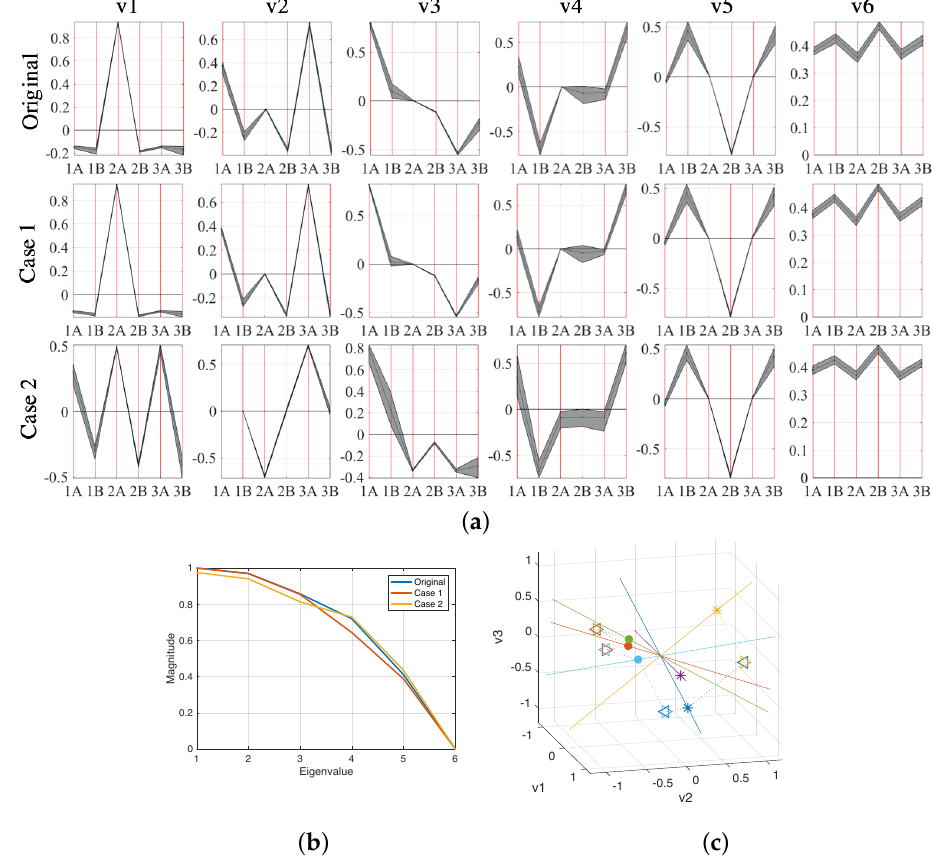
Figure 3. Details of the toy example. ( a ) Analysis of the obtained eigenvectors in the three cases of the toy example and their bootstrap confidence intervals. ( b ) Eigenvalues for the three cases. ( c ) Projections of the different occurrences on the eigenvectors. The 6 lines represent the 6 dimensions of the eigenvectors, which cross through each of the categories taking place individually and represented by points and asterisks. Crossed triangles represent the joint occurrences of categories represented by their colors. These joint occurrences are in the subspace delimited by the lines from each of the involved categories in the linear combination of said